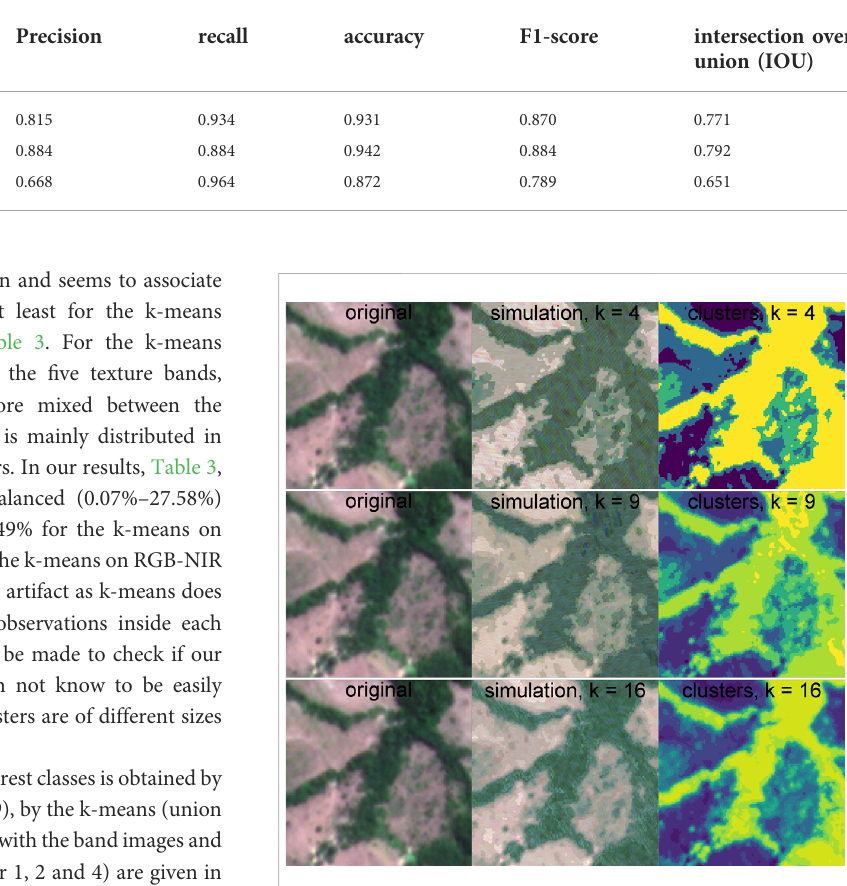
TABLE 4 Metrics of segmentation accuracy computed between the Mapbiomas forest class (reference) and the forest classes obtained with the k-textures and the k-means.